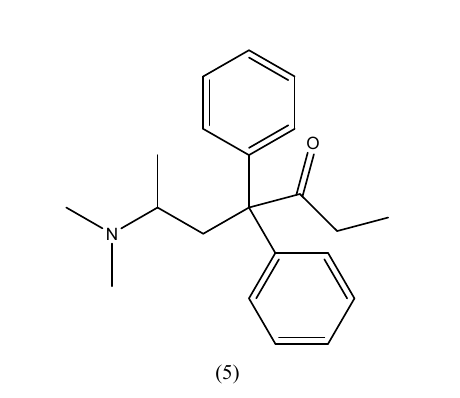
Figure 2. The structure of methadone ( 5 ).